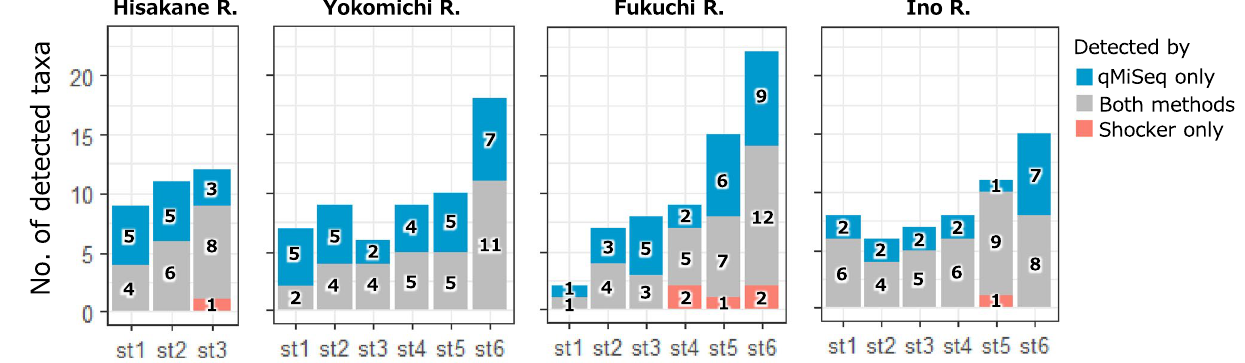
Figure 3. The number of taxa detected by eDNA metabarcoding with qMiSeq (blue), a capture-based survey using electrical shocker (pink) or both methods (grey) at each study site of each river.